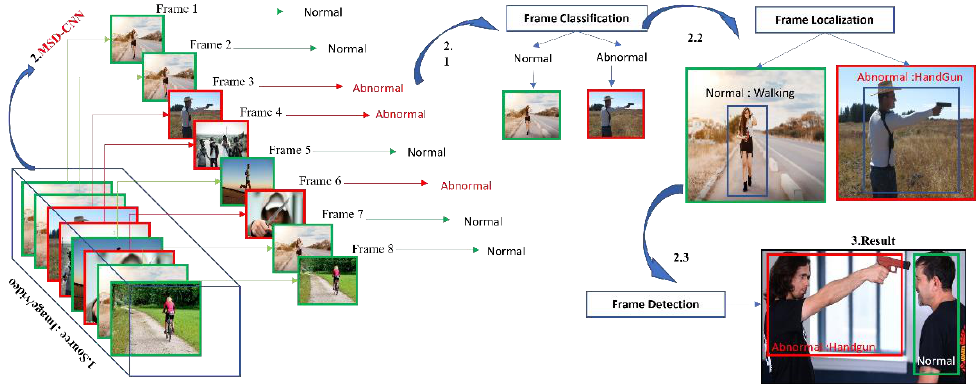
Figure 1. System overview: 1. We first obtain the desired input video or images. 2. On that sequence of frames, the MSD-CNN model is used first. 2.1 Frame classification, 2.2 Frame Localization, and then 2.3 Frame Detection. 3. We can obtain the result.